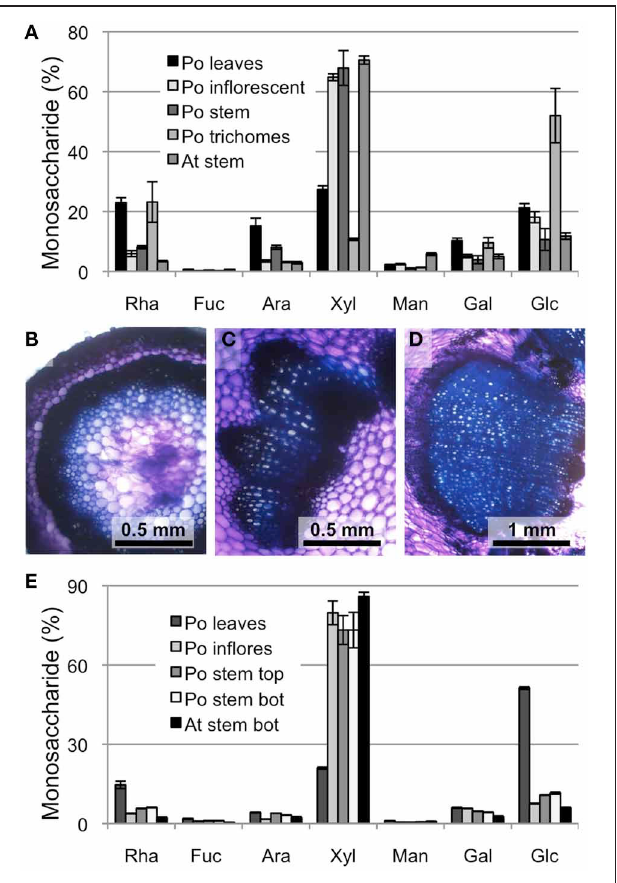
FIGURE 1 | Cell wall analysis of psyllium aerial tissues. (A) Neutral monosaccharide composition of total cell walls from various tissues from psyllium (Po) leaves, inflorescent, stem and trichomes and Arabidopsis (At) stem. (B–D) Toluidine blue staining of free-hand sections of psyllium inflorescence (B) , stem top (C) and stem bottom (D) . (E) Neutral monosaccharide composition of 1M KOH extractions of various tissues from psyllium leaves, inflorescent, stem top and stem bottom, and Arabidopsis stems bottom. The selected tissues were subjected to sequential extractions with CDTA, Na 2 CO 3 and 1M